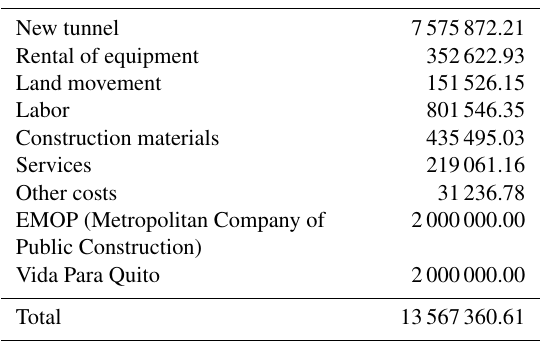
Table 3. List of the costs of the reconstruction in USD. Data from MDMQ (2005).